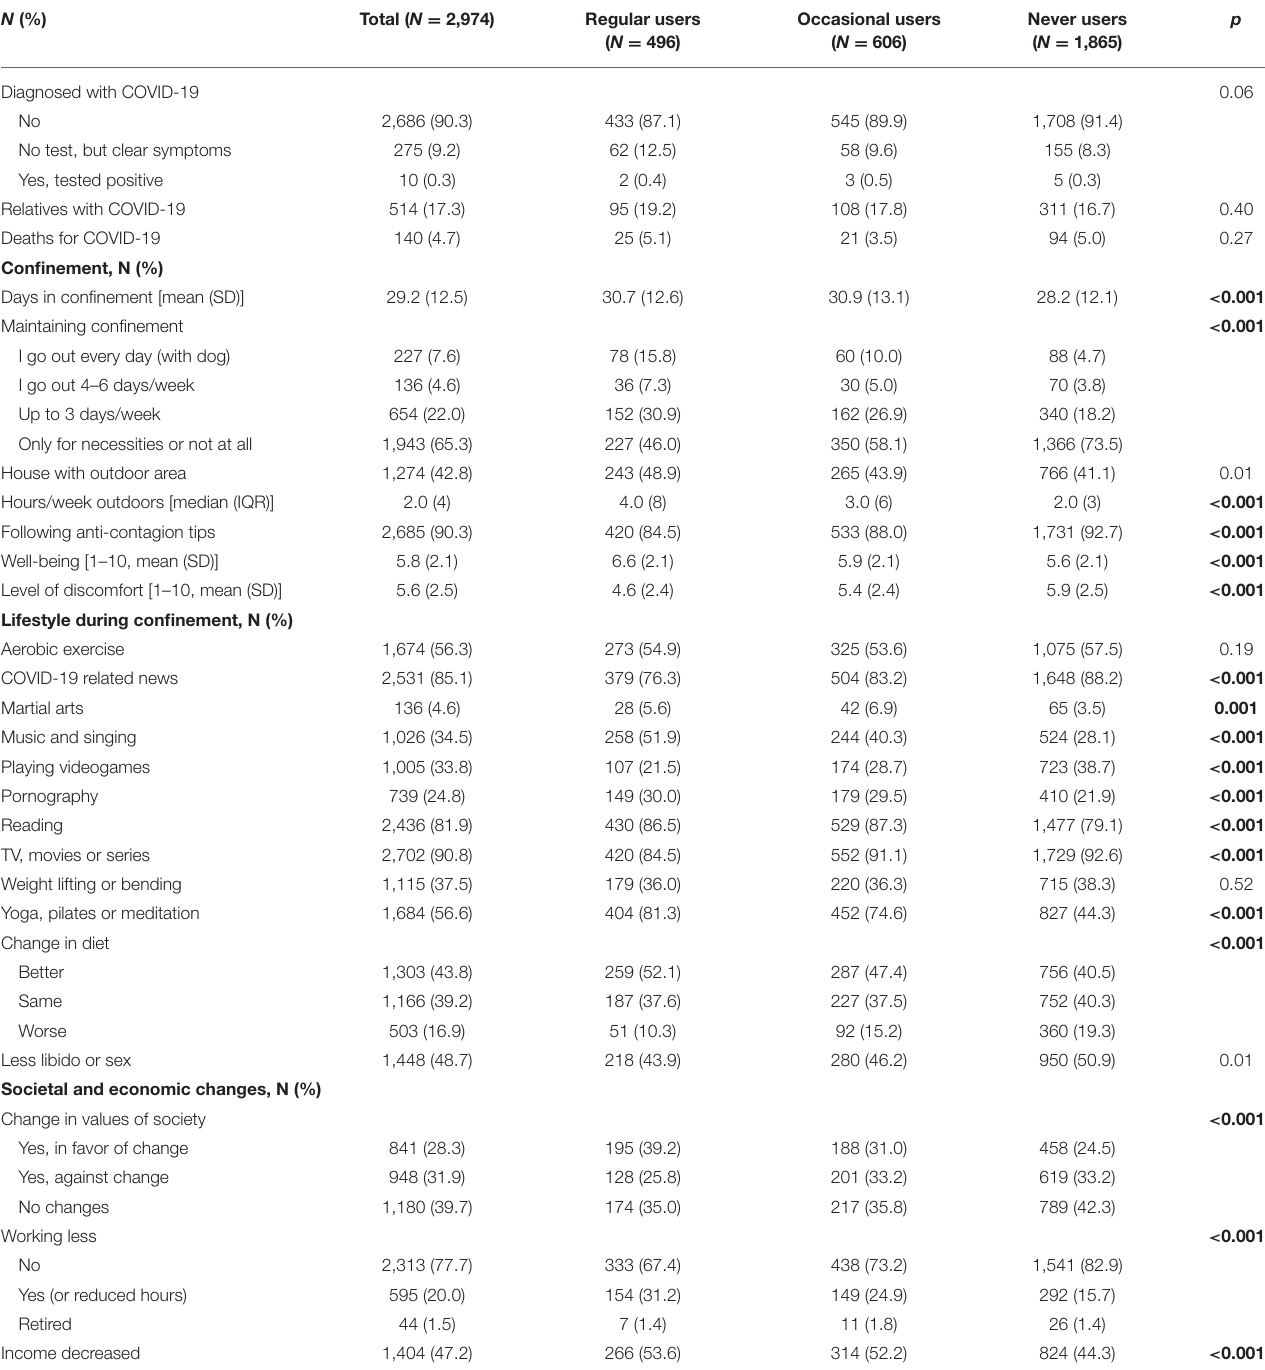
TABLE 2 | Preliminary factors related to COVID-19 and the confinement period in the total sample, and in regular vs. occasional vs. never users of psychedelic substances in the past. N